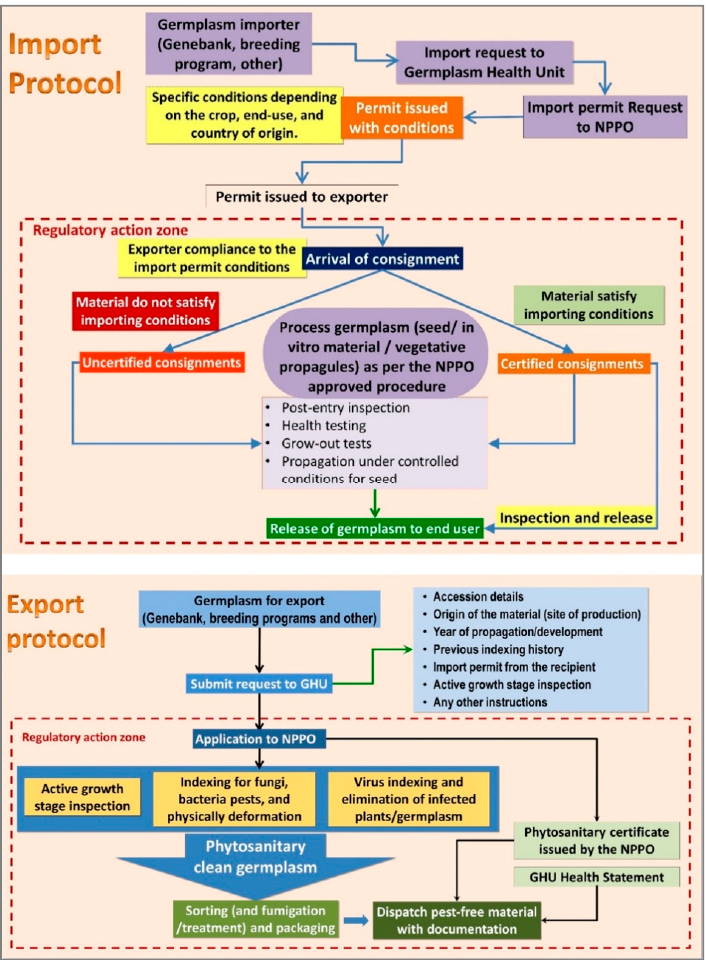
Figure 2. Schema of the germplasm import and export protocol of the CGIAR centers, which is executed in collaboration with the host country national plant protection organization (NPPO). The activities conducted under NPPO monitoring are marked as the ‘regulatory action zone’. Permit = an official document issued by the NPPO authorizing the centers to transfer materials; country of origin = country in which the germplasm is